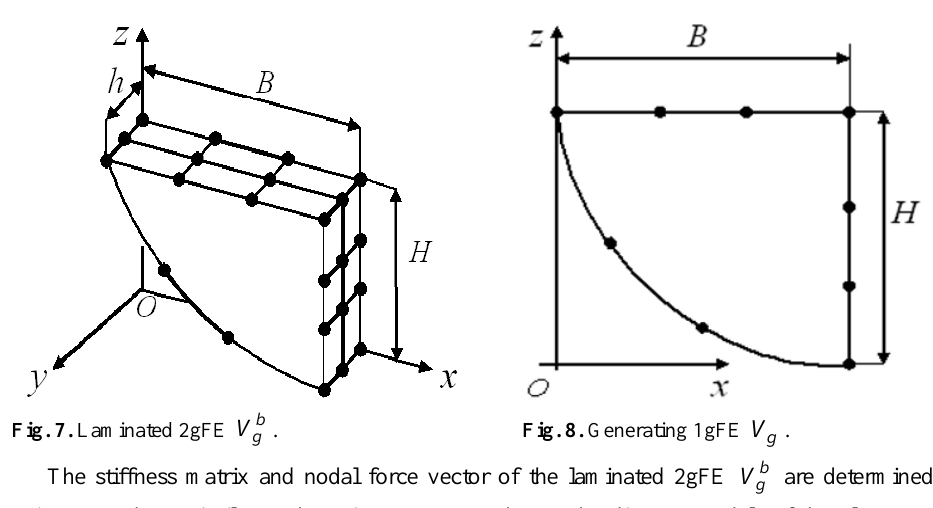
Fig. 7. Laminated 2gFE b g V . Fig. 8. Generating 1gFE